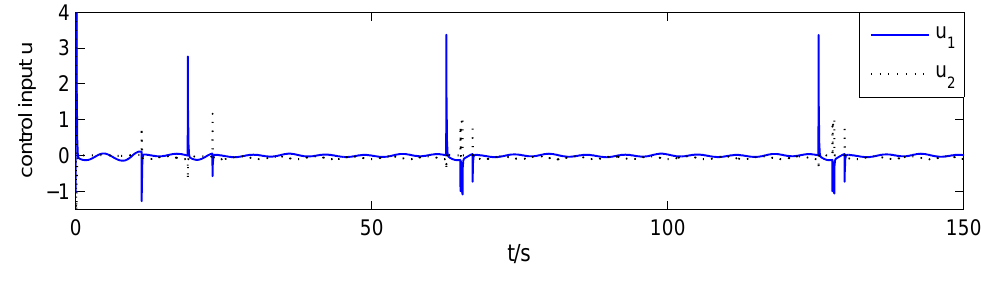
Figure 7. Tracking performance of output y